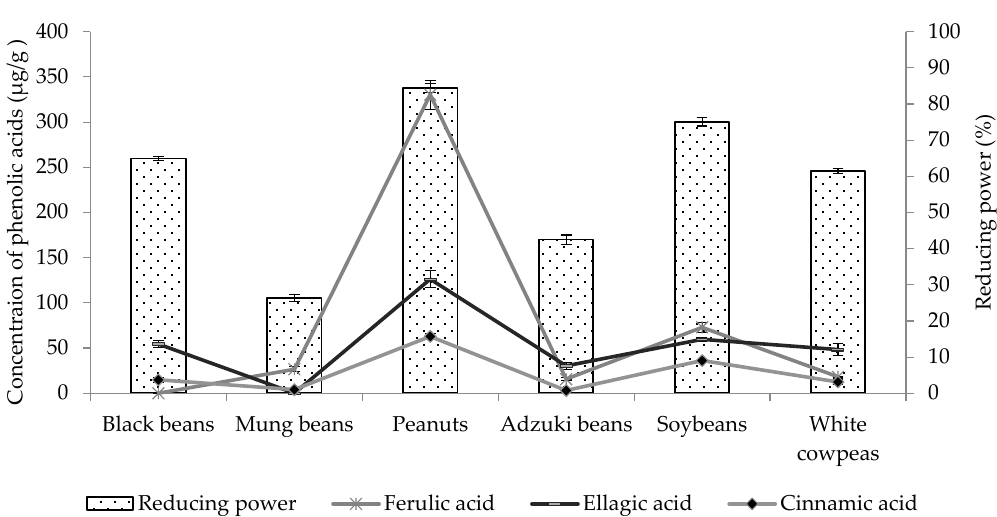
Figure 2. Correlation between 1,1-diphenyl-1-picrylhydrazyl (DPPH•) radical scavenging activity and concentrations of detected phenolic acids.